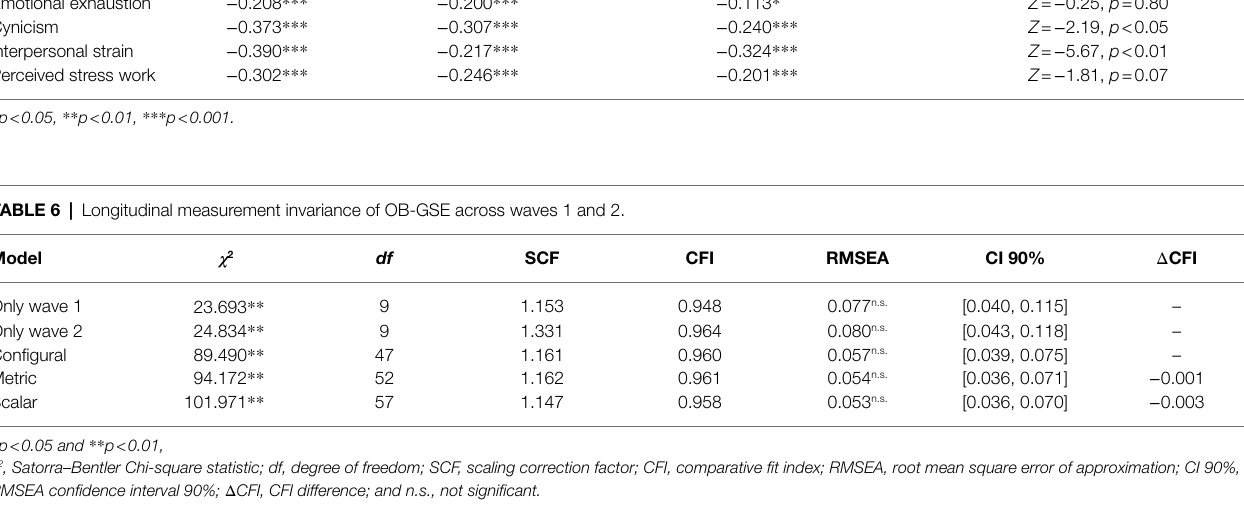
Semipartial r correlation for OB-GSE Comparison between correlations (controlling for Pierce et al. scale) (Hittner et al., 2003)